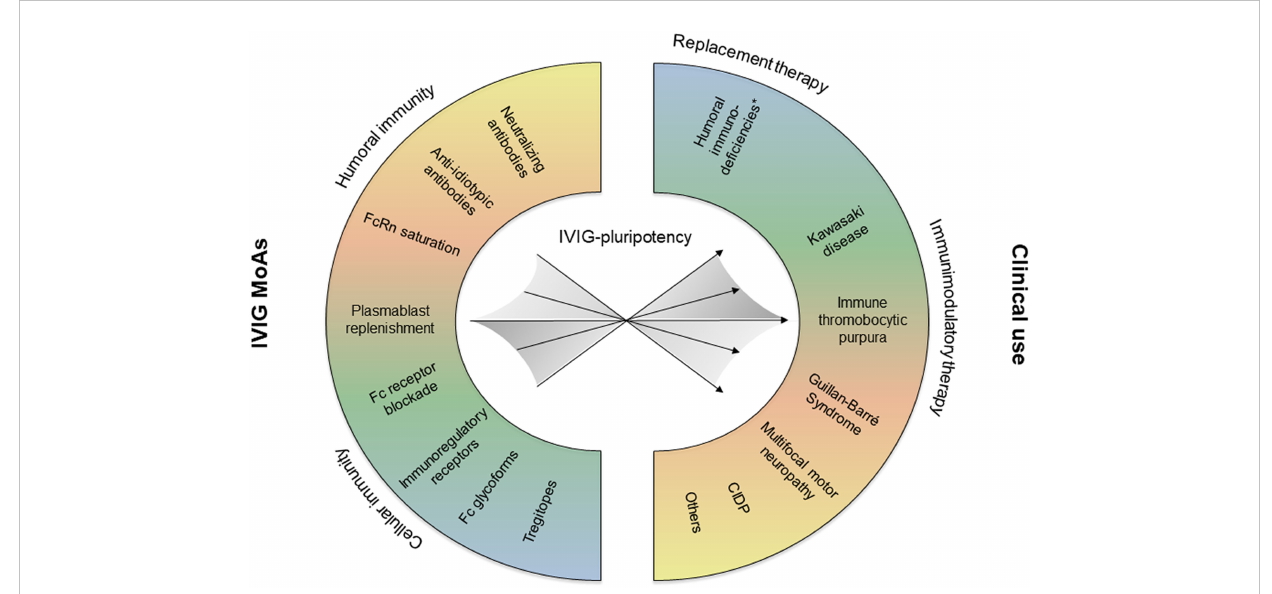
FIGURE 1 Depending on the pathophysiology of the treated disease, different IVIG mechanisms of action (MoAs) may be effective, and eventually act in concert. CIDP, chronic in fl ammatory demyelinating